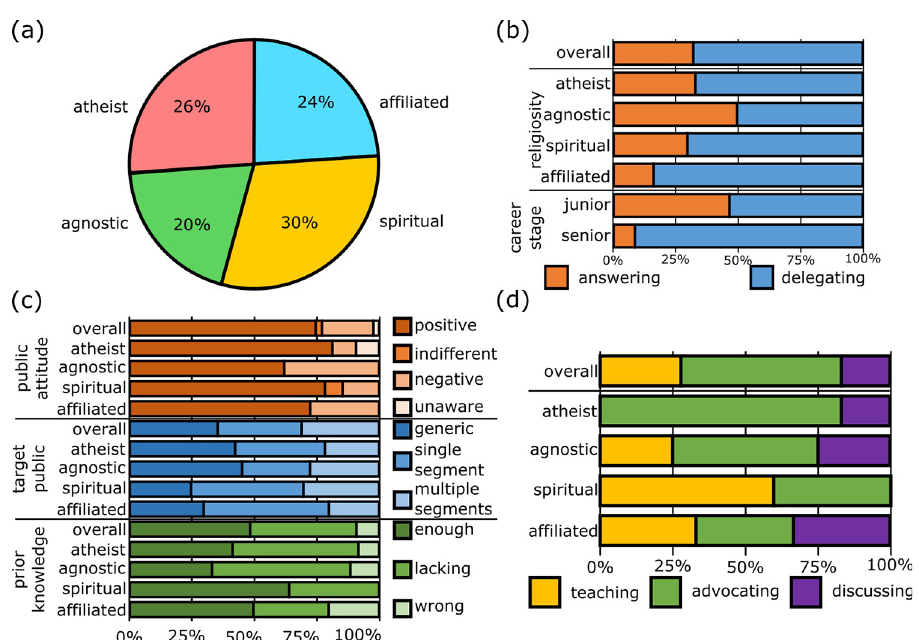
PLOS ONE | https://doi.org/10.1371/journal.pone.0282243 February 24,